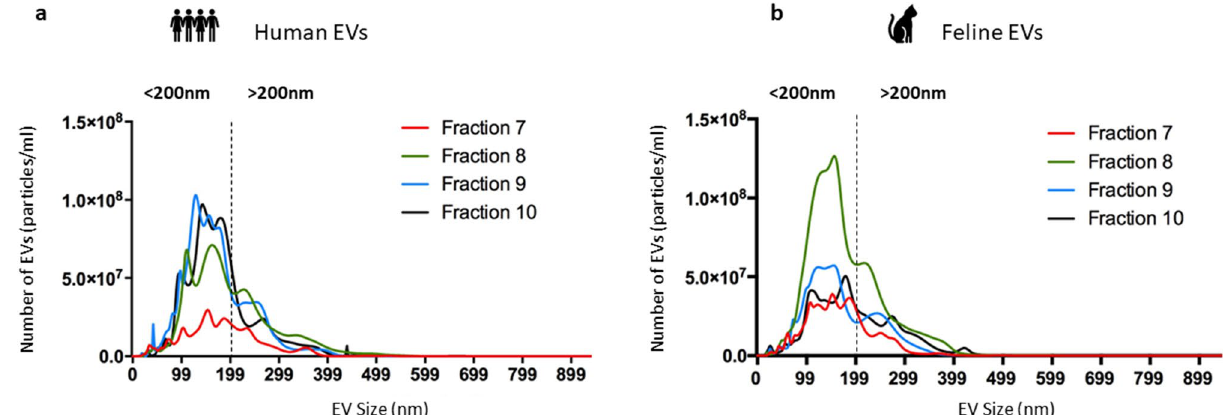
Figure 3. Nanoparticle tracking analysis of fractions 7–10 showing the size range and concentration of all EVs isolated from human and feline plasma. (a) NTA of particles isolated from human plasma shows that the peak in EV concentration is below 200 nm for fraction 7 (−) (mode: 168.0 ± 23.5 nm), fraction 8 (−) (mode: 170.0 ± 19.5 nm), fraction 9 (−) (mode 143.0 ± 15.8 nm) and fraction 10 (−) (mode: 176.3 ± 6.4 nm). A population of vesicles greater than 200 nm are also present in fraction 7 (D90: 286.6 ± 23.9 nm), fraction 8 (−) (D90: 347.6 ± 15.1 nm), fraction 9 (−) (D90: 275.0 ± 14.9 nm), fraction 10 (−) (D90: 300.9 ± 24.8 nm). ( b) NTA of particles isolated from feline plasma shows the EV concentration is below 200 nm for fraction 7 (−) (mode: 110.0 ± 28.3 nm), fraction 8 (−) (mode: 172.0 ± 11.5 nm), fraction 9 (−) (mode: 137.0 ± 11.5 nm) and fraction 10 (−) (mode: 137.0 ± 20.4). A population of vesicles greater than 200 nm are also present in fraction 7 (−) (D90: 250.6 ± 8.7 nm), fraction 8 (−) (279.0 ± 17.4 nm), fraction 9 (−) (D90: 298.8 ± 13.0 nm), fraction 10 (−) (D90: 246.1 ± 28.7